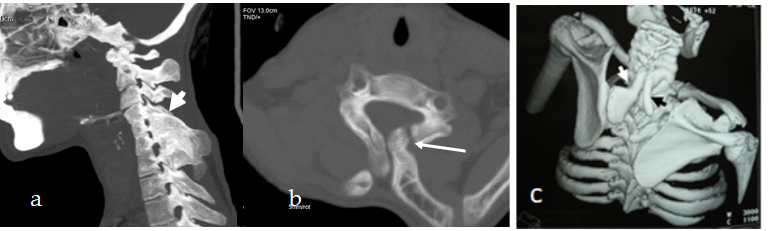
Figure 5. ( a , b ) Three-dimensional sagittal CT scan of an 18-year-old-girl with MURCS association showed cervical kyphosis with massive fusion of the cervical vertebrae (extensive fusion of C4-7 associated with fused spinous processes), a deformity that is extremely surprising ( a ). Axial 3D reformatted CT scan of the C7 showed true bony bridge between the omoplate and spine that resulted in the development of omovertebral bone ( b ). Three-dimensional reconstruction CT scan in a 16-year-old girl presented with torticollis, progressive cervico-thoracic kyphosis and bilateral omo-vertebral bones originated from the 7th cervical spine. Apparent omovertebral bone connecting the 7th cervical spine with the superior border of the left scapula (white arrow) gives rise to the development of Springle’s deformity ( c ).